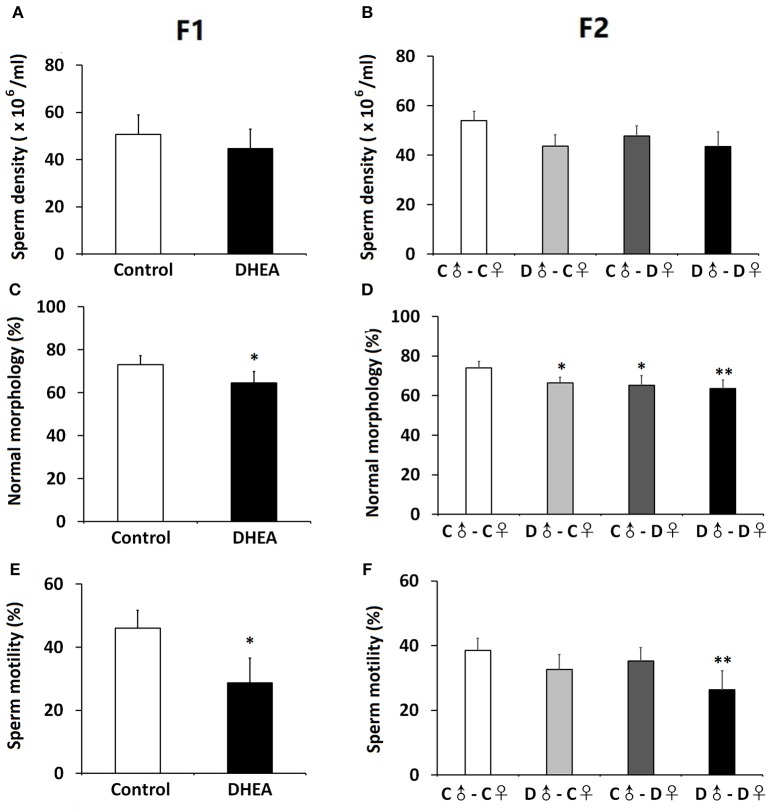
Sperm quality of male offspring. We did not detect changes in the sperm density of F1 (A) or F2 (B) offspring. the survival rate of sperm (B) in F1 rats. The proportion of morphologically normal sperms was lower in both F1 (C) and (D) F2 rats. (E) F1 male offspring showed normal sperm mobility. (F) The D♂-D♀ group showed decreased sperm mobility. n = 12 for each group. *p < 0.05, **p < 0.01, compared with the control group, one-way ANOVA with Bonferroni post hoc test.